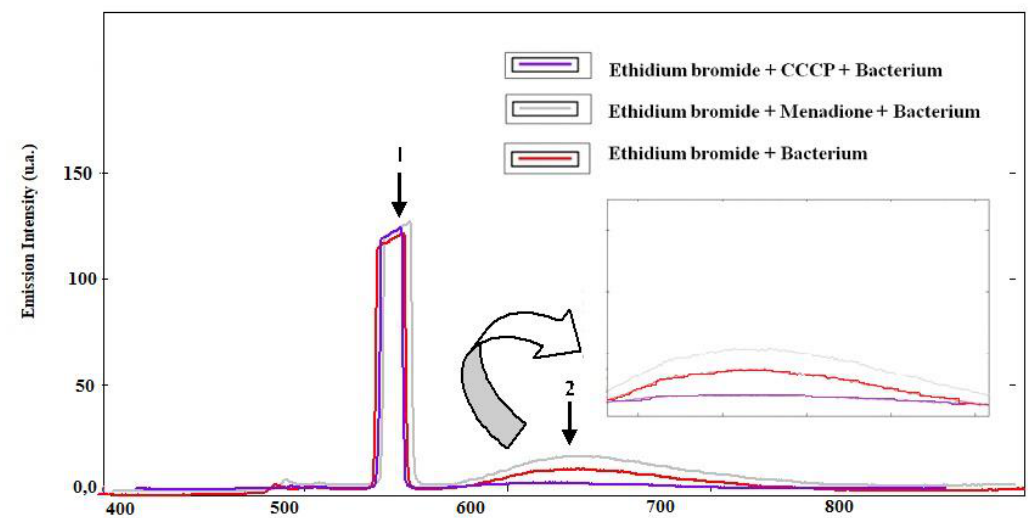
Figure 2. Inhibition of e ffl ux pump by increasing fluorescence. 1—Peak corresponding to the other bacterial constituents. 2—Peak corresponding to ethidium bromide. Inhibition of e ffl ux pump by increasing fluorescence. Carbonyl Cyanide m-Chlorophenylhydrazine (CCCP).